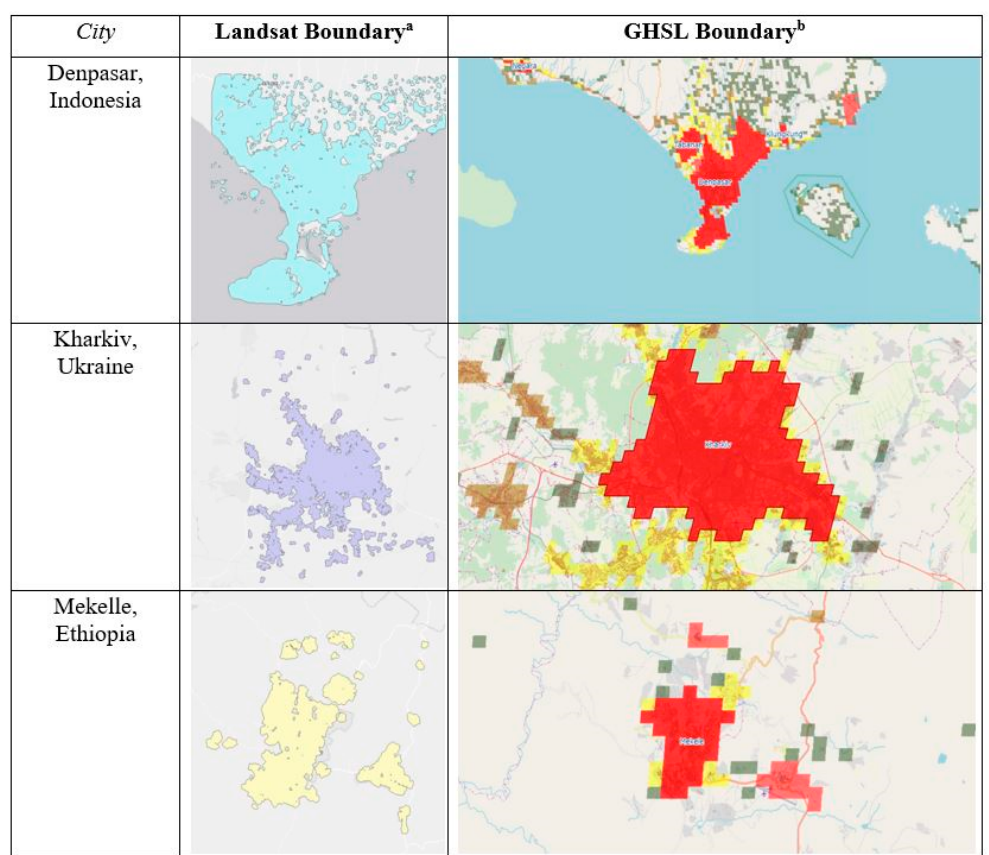
Figure 6. City extent comparison between Landsat classified boundary and GHSL boundary epochs. a Landsat boundary derived from supervised classification of Landsat imagery. b GHSL boundary downloaded from Urban Centre Database UCDB R2019A, https://ghsl.jrc.ec.europa.eu/ucdb2018visual.php (accessed date: 15 July 2021). Table 8. LUE (Land Use Efficiency) and UN-LCRPGR ratio